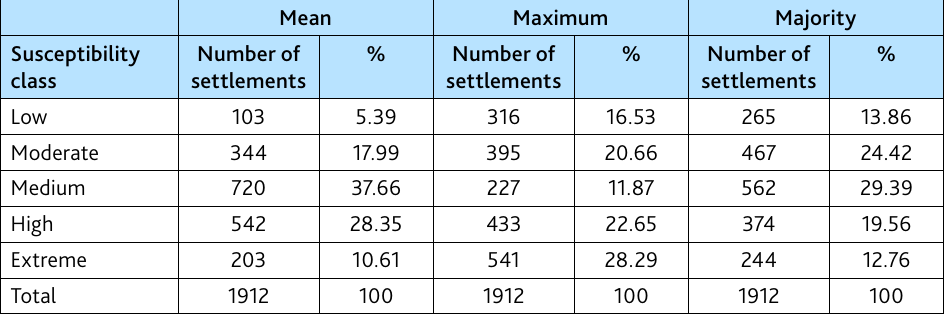
rankings based on the mean, maximum and majority raster Table 3. Statistics of the FFSI s